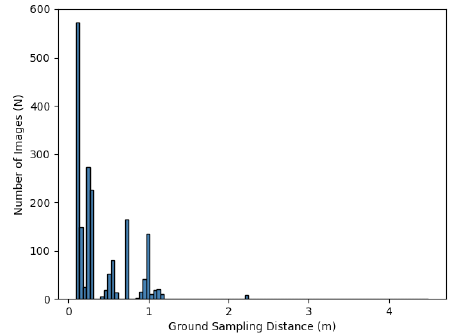
Figure 12. The histogram represents the spatial resolution distribution of the images in the “A Large-Scale Dataset for Object Detection in Aerial images” (DOTA) dataset. Due to the lack of the annotated files of the test set, we only counted the data from the training set and the validation set. The spatial resolution values come from the ground sampling distance (GSD) data in the second line of the annotated files. There are 1869 annotated files in total, and only 1846 files have the ground sampling distance (GSD)